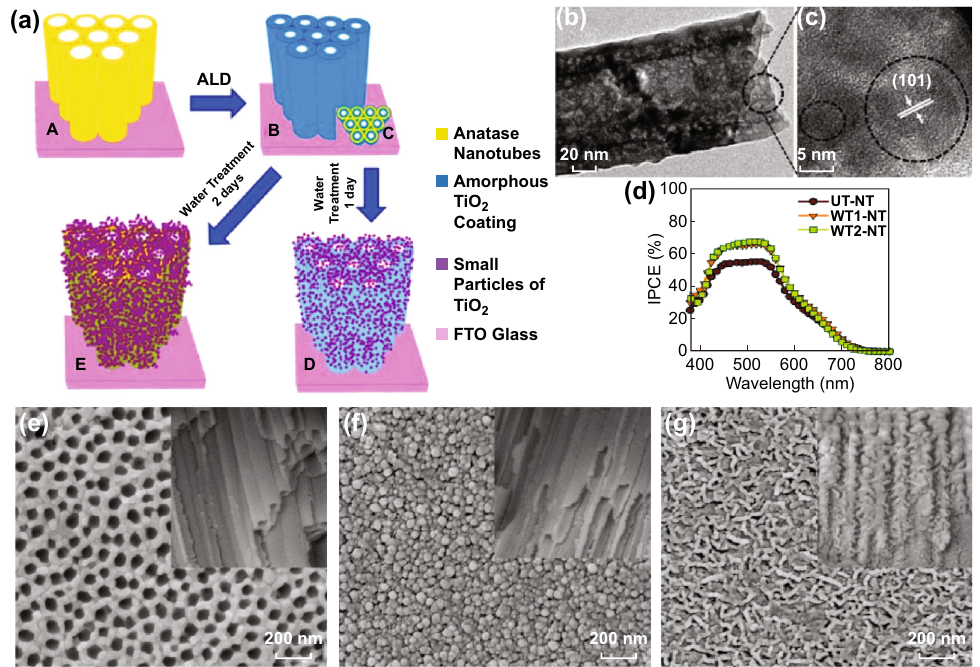
Fig. 11 a Schematic illustration of the fabrication stages of the nanoparticle decorated TiO 2 NT array photoanode: (A) untreated TiO 2 NT array on FTO substrate (UT-NT), (B) ALD amorphous TiO 2 thin layer coated on the TiO 2 NT array (AT-NT), (C) cross-sectional view of (B), (D) AT- NT electrode post-water treated for 1 day (WT1-NT), and (E) AT-NT electrode water treated for 2 days (WT2-NT). b TEM image of the sample after water treatment. c The corresponding HRTEM lattice images of the circled portions in b . d Incident photoconversion efficiency spectra of DSSCs using untreated and water-treated TiO 2 NT array photoanodes. SEM images of e as-anodized TNTs, f after being immersed in water at 90 (cid:3) C for 8 h, and g after being immersed in ammonia solution (the concentration of Vol ammonia /Vol water = 1:1) at 90 (cid:3) C for 8 h [45,